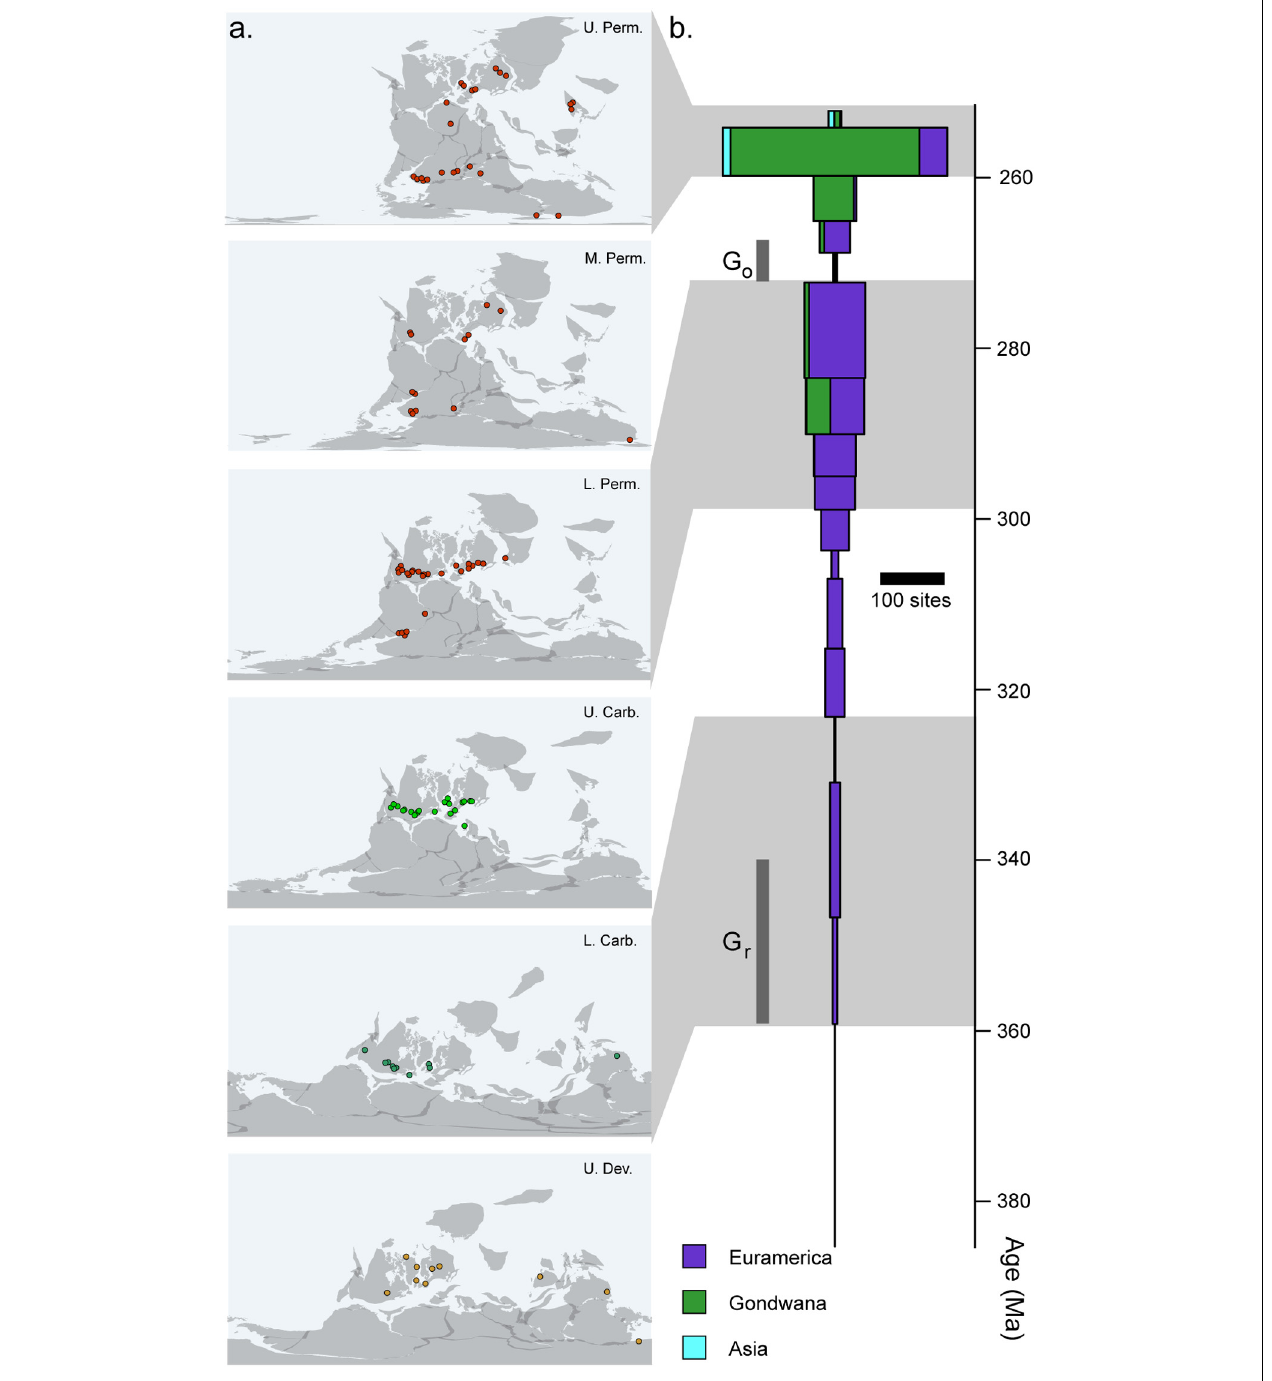
FIGURE 4 | Completeness of the early tetrapod record. (A) Geographic distribution of tetrapod fossil localities across the late Palaeozoic. (B) Number of tetrapod-bearing localities recorded in the Paleobiology Database (http://paleobioDB.org) by stage, showing heterogeneity in regional and temporal